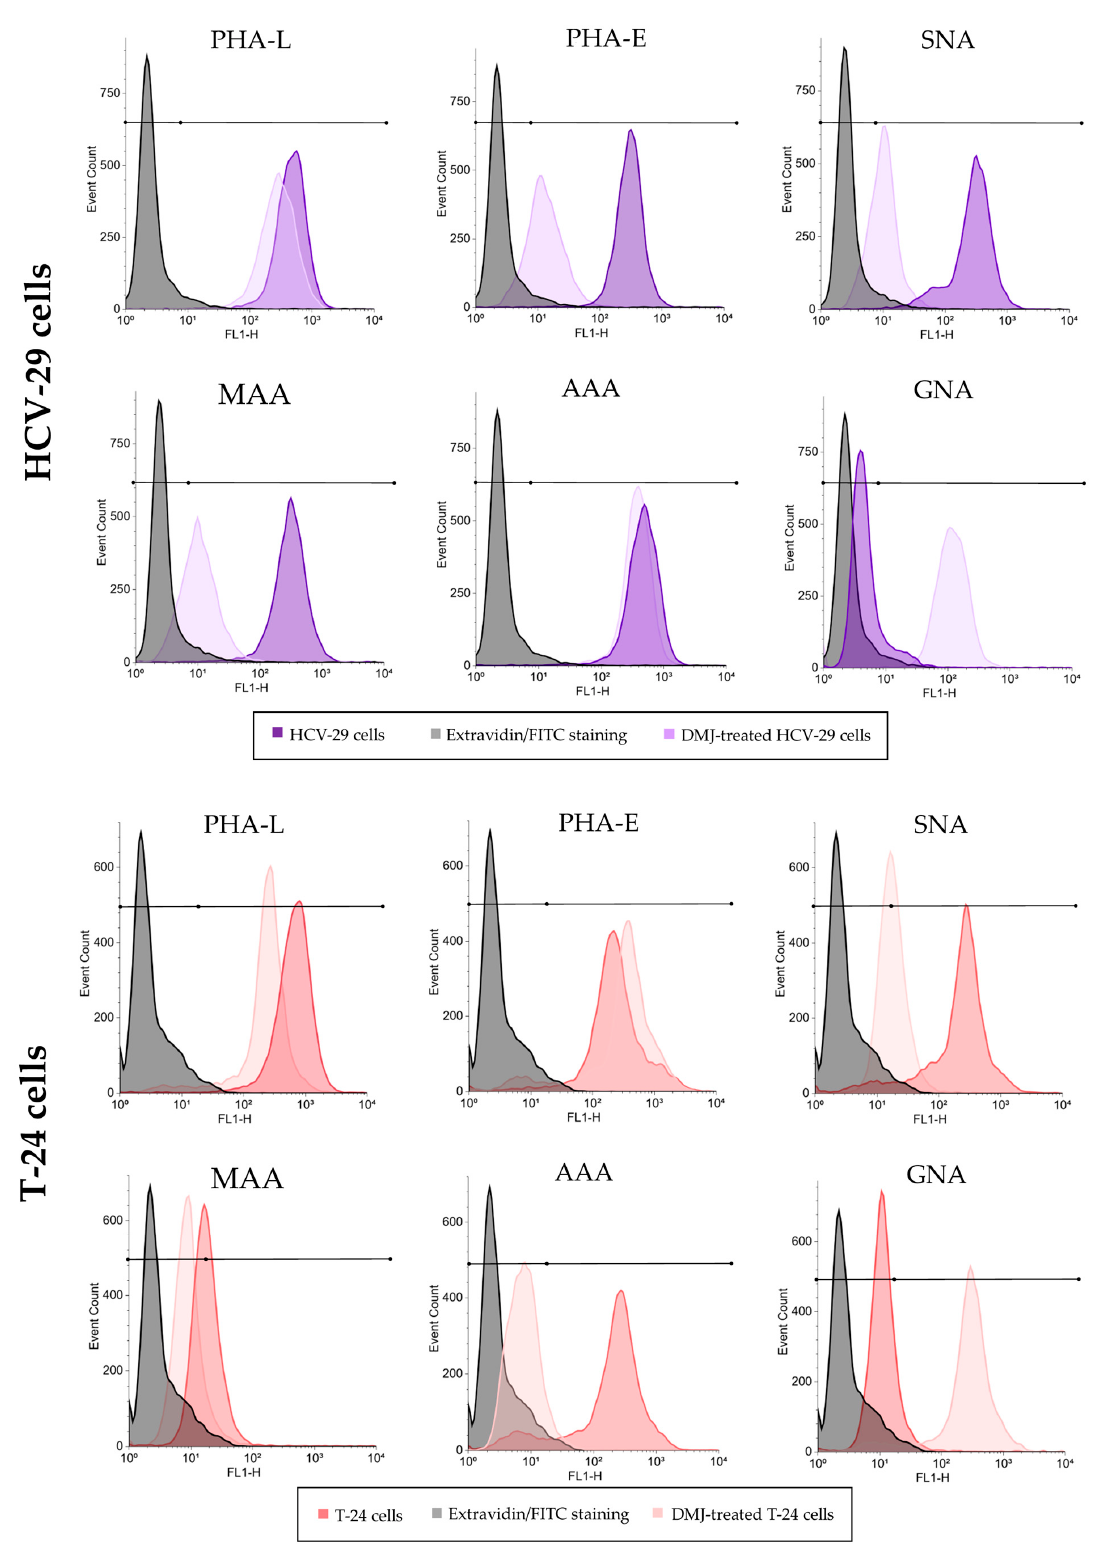
Figure 9. Flow cytometry analysis of surface glycosylation of HCV-29 and T-24 cells grown in control conditions and treated with DMJ. Histograms for MAA-, SNA-, GNA-, AAA-, PHA-E- and PHA-L-positive cells. Colored areas represent stainings with a panel of six lectins, while grey histograms represent background fluorescence of unspecific binding of FITC-extravidin. The X axis shows log fluorescence intensity, Y axis shows the number of